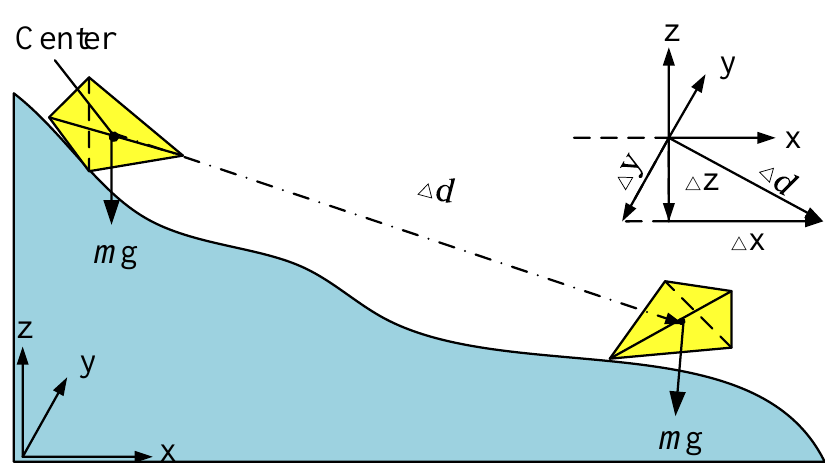
Figure 3. A simple illustration of the displacement of a rock block under gravity.